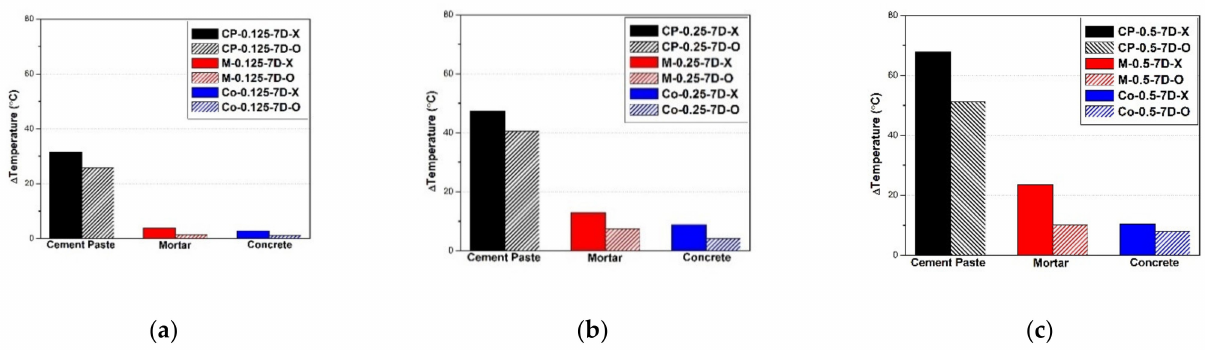
Figure 5. Temperature variations by voltage supply for 7 curing days: ( a ) 0.125 wt%, ( b ) 0.25 wt%, and ( c ) 0.5